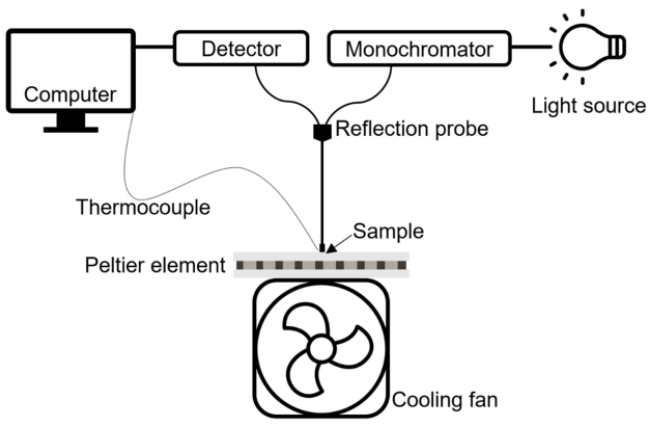
Figure 11. The scheme of the installation for measuring luminescence at 15 –90 °С.